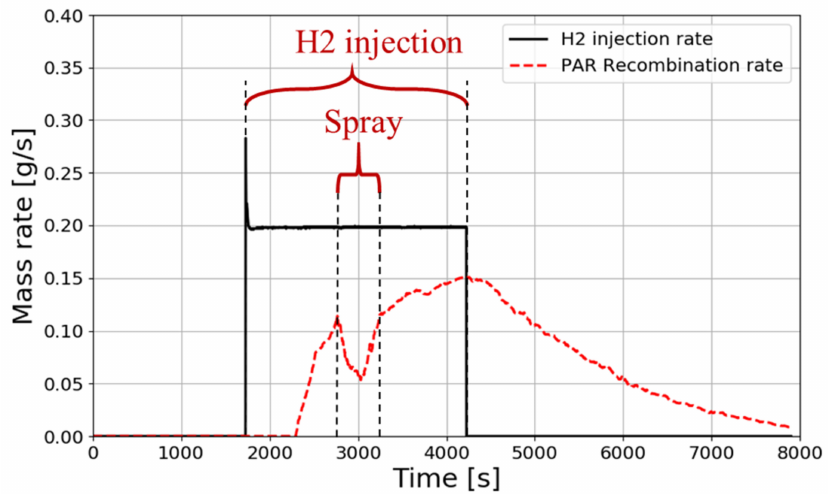
Figure 28. Changes in hydrogen injection and recombination during the SSP4